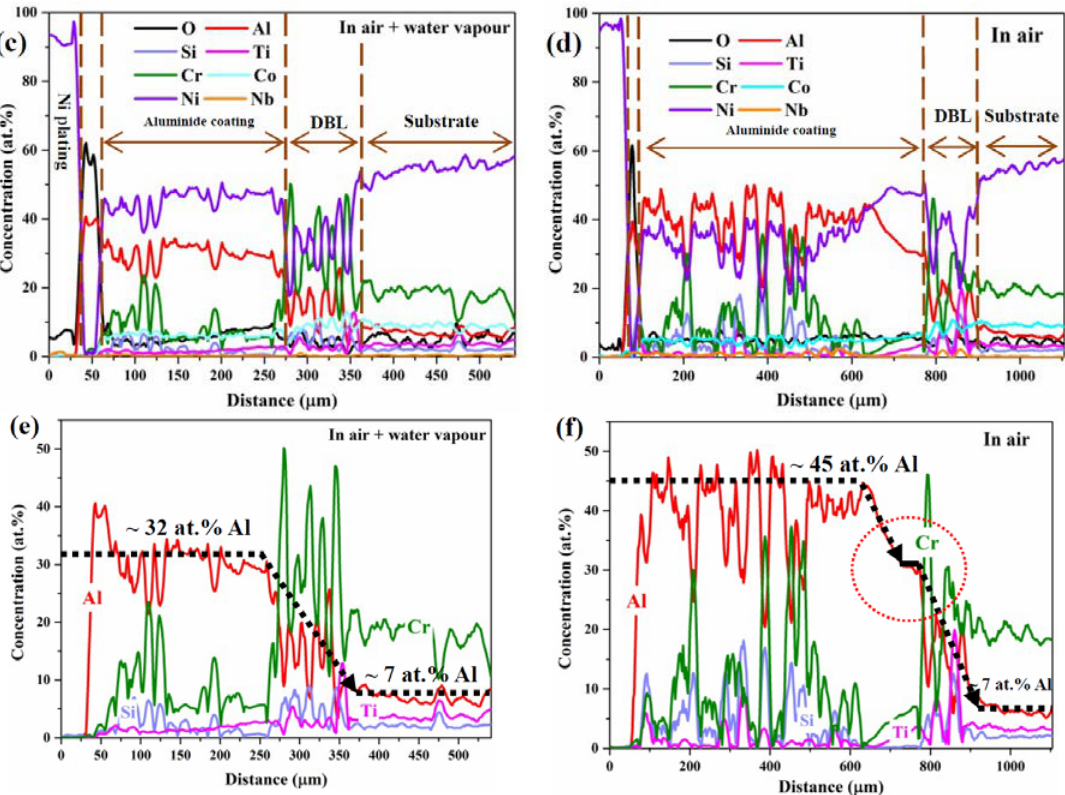
Figure 6. Cross-sectional micrograph of aluminide coatings oxidized at 1050 °C for 150 h: ( a ) in air plus water vapour and ( b ) in air; corresponding EDX line profiles of elemental distributions across the coating layer on an IN738 superalloy ( c , e ) in air plus water vapour; ( d , f ) in air.